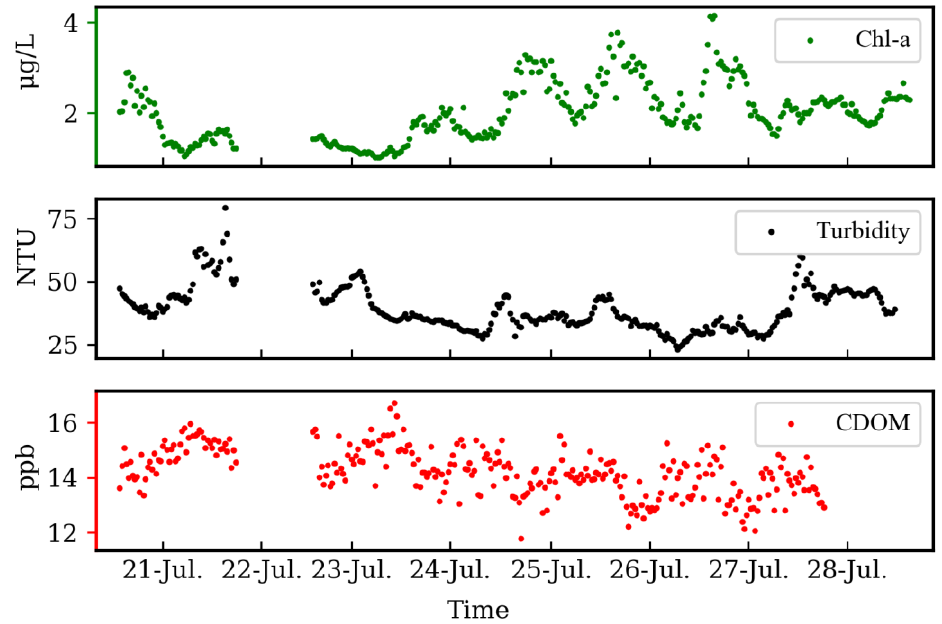
Figure 11. The concentration of Chl-a, Turbidity, and CDOM (Colored Dissolved Organic Matter) in the deployment site (Figure 7) from 20 July 2013, to 28 July 2013.